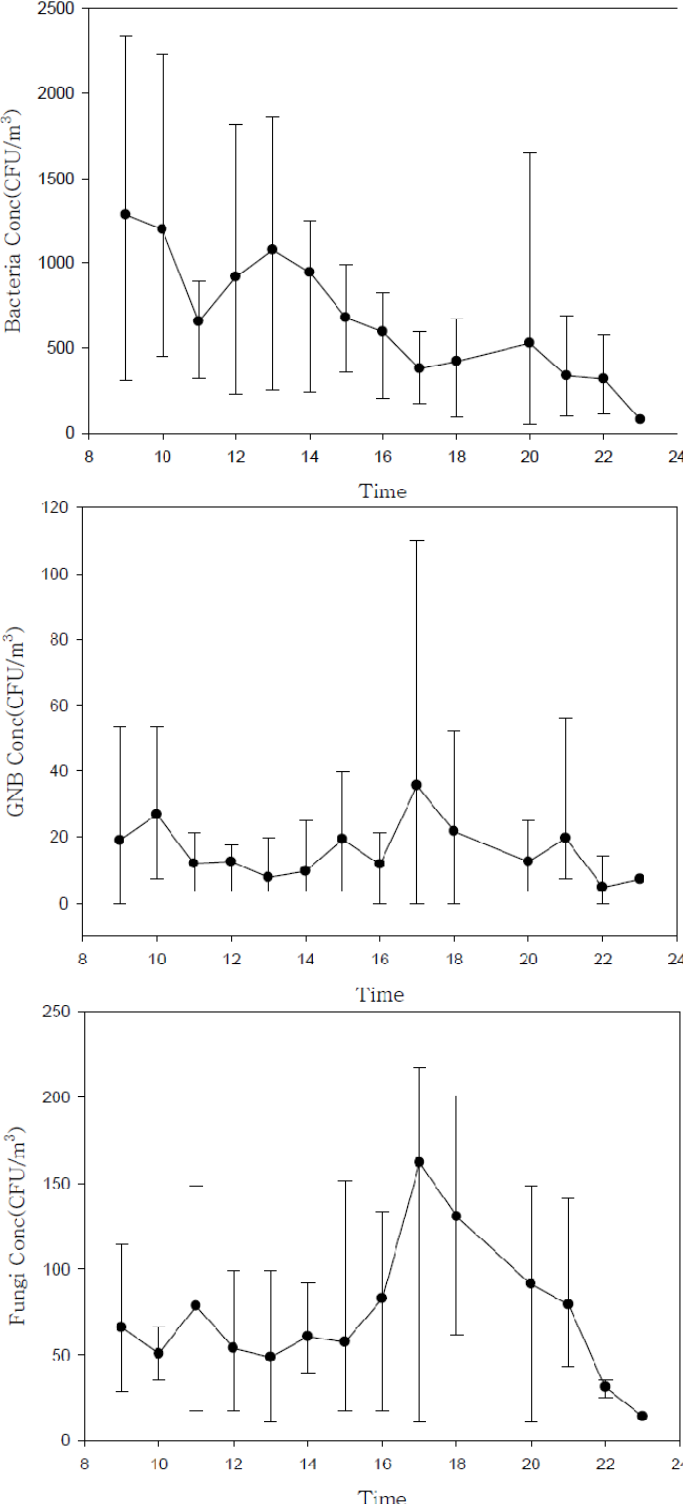
Figure 1. Daily variation in airborne microorganism concentrations (mean and range measured at six hospitals during summer, fall, and